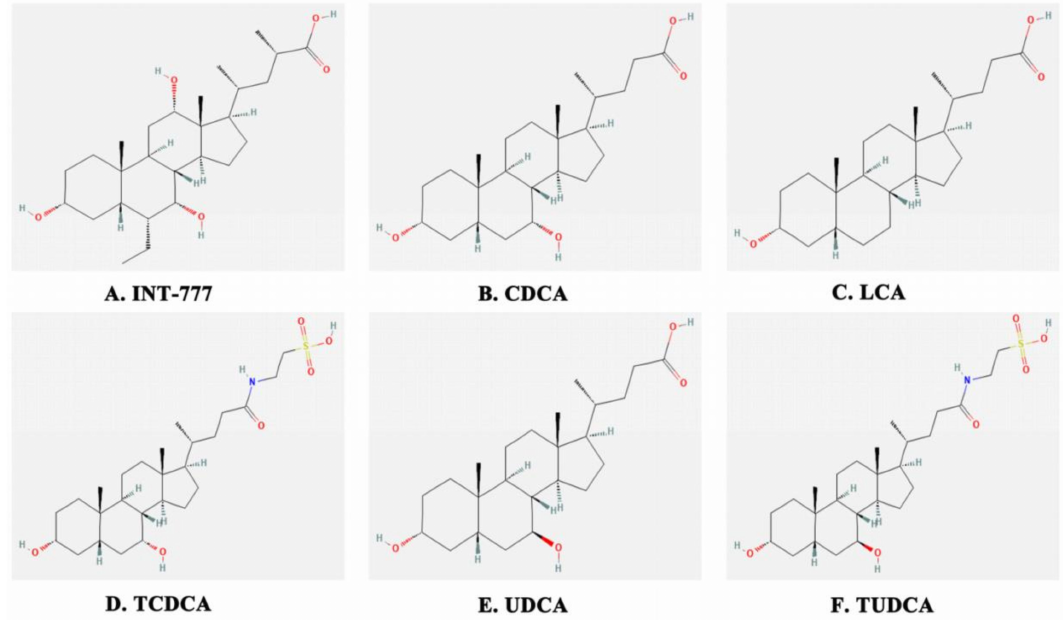
Figure 1. The chemical structures of the bile